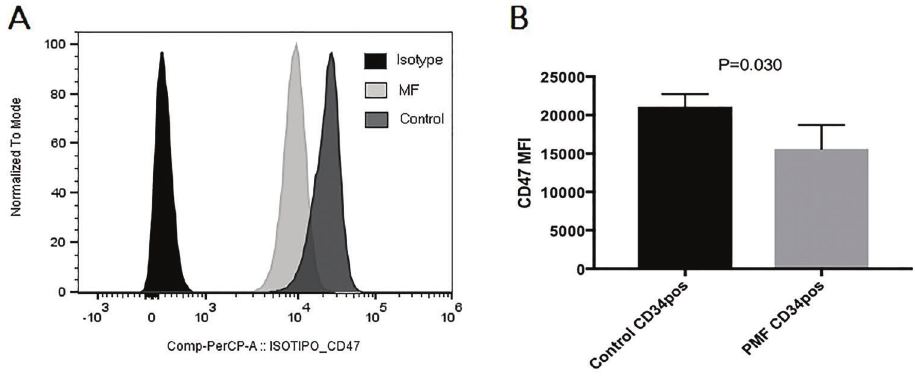
Figure 2. CD47 expression in control vs myelo fi brosis (MF) CD34-positive (pos) cells. A , Histogram of representative experiments; B , Comparison of average mean fl uorescence intensity (MFI). Data are reported as mean ± SD; Welch-corrected Student ’ s t -test. PMF: primary myelo fi